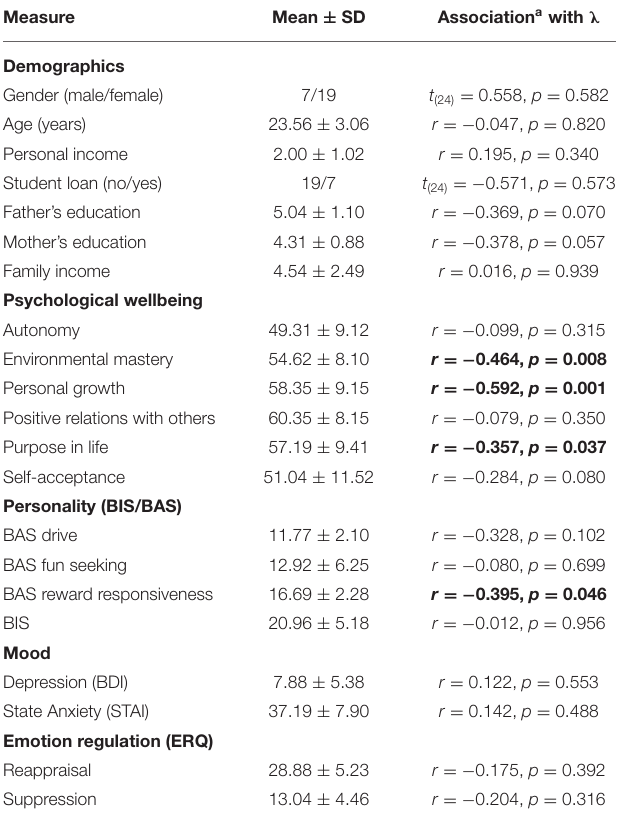
TABLE 1 | The score of each measure and their association with λ .